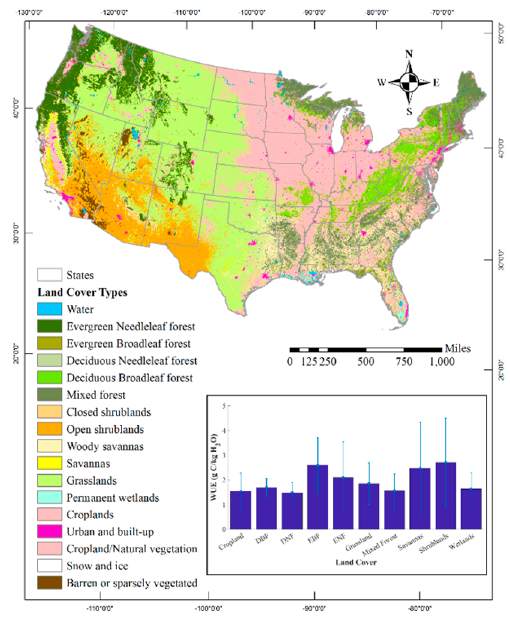
Figure 3. Spatial distribution of land cover over the CONUS and the average WUE of each biome during 2000–2014. The lines indicate ± 1 standard deviation for each